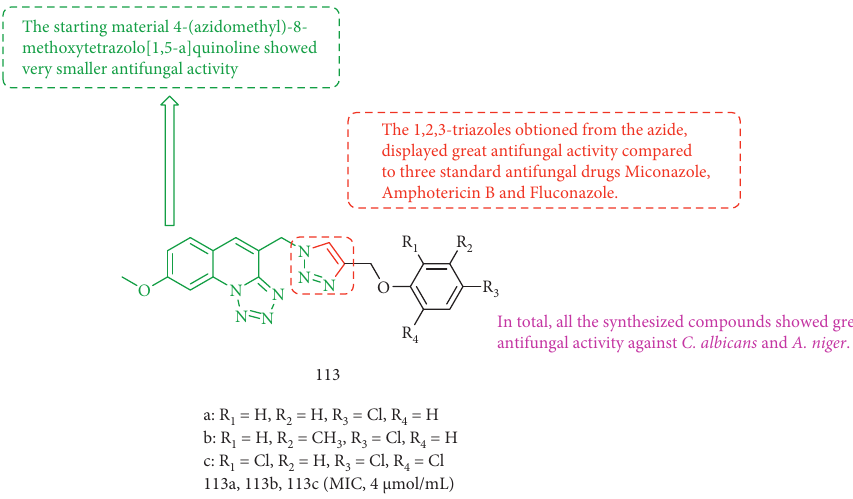
Figure 52: Chemical structure of tetrazoloquinoline-1,2,3-triazole